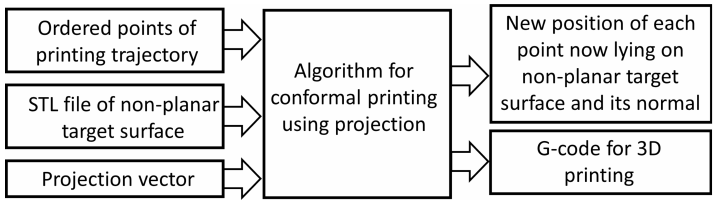
Figure 2. Block diagram of the algorithm presented in this work.